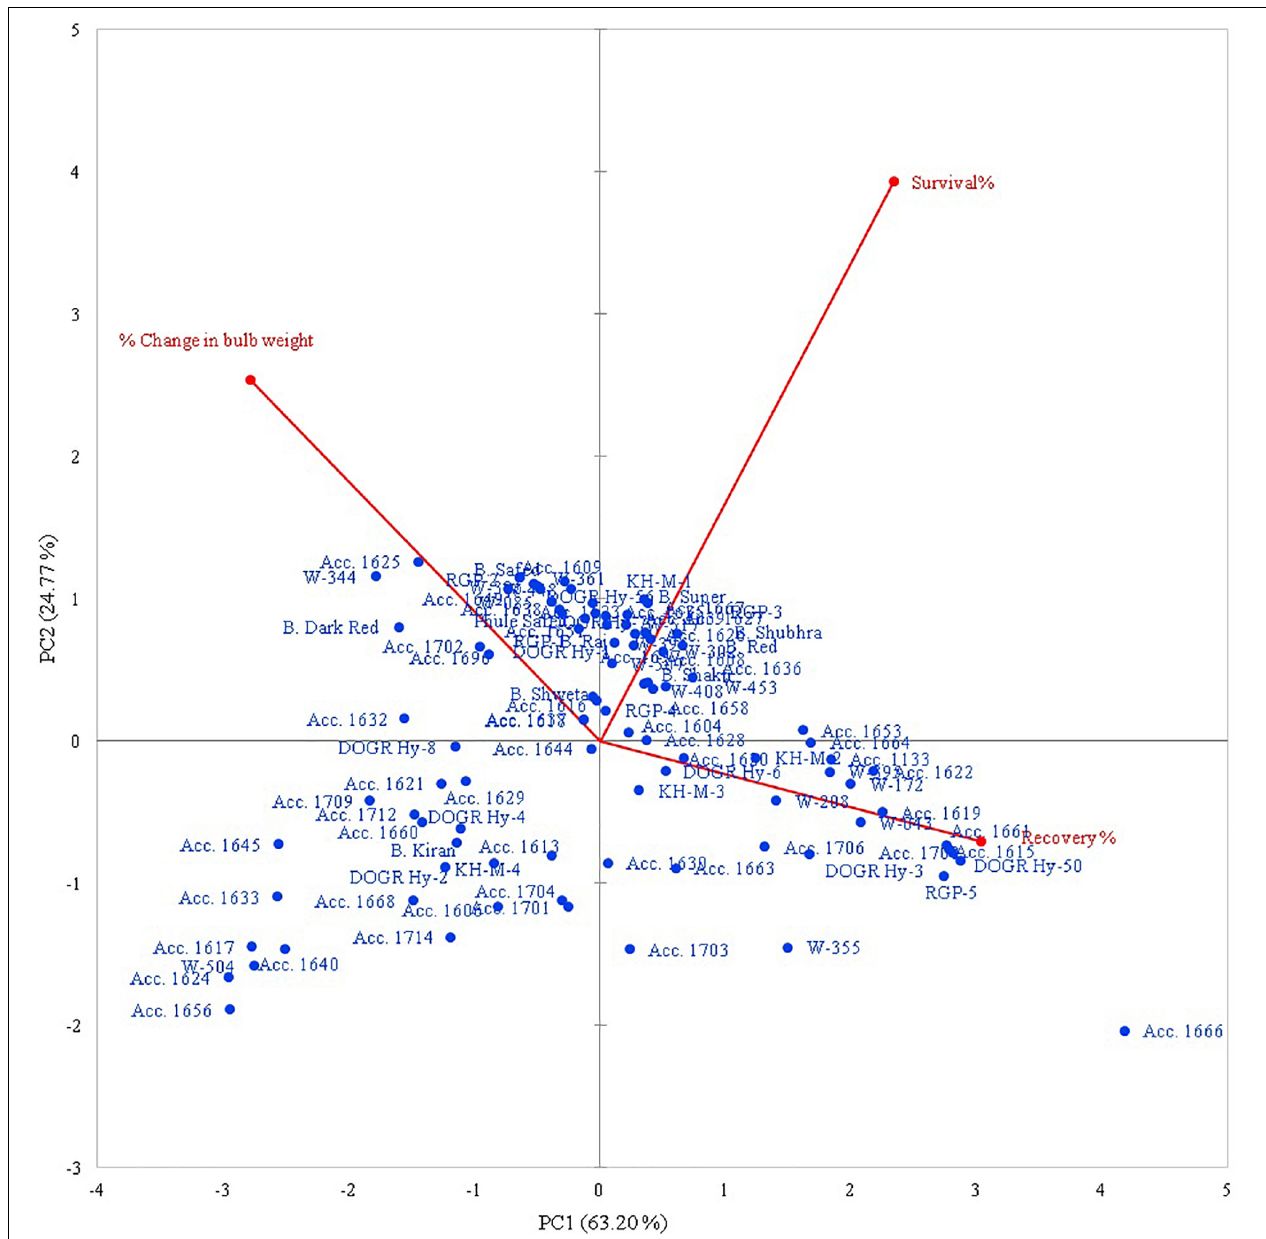
FIGURE 1 | Principal component of the genotypic trait grouping under waterlogging